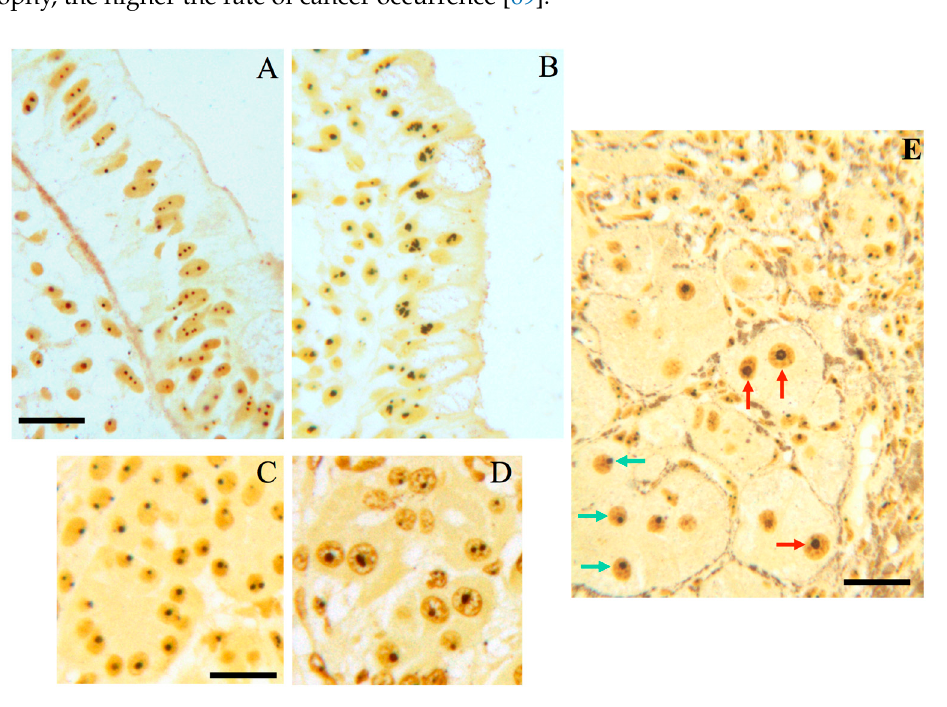
Figure 4. Chronic inflammatory diseases and nucleolar hypertrophy; ( A ) histological sections from normal human colon and ( B ) from human colon with ulcerative colitis (UC), after selective silver staining for NOR proteins. The size of nucleoli of the epithelial cells lining the surface of the normal mucosa is smaller than that of the epithelial cell nucleoli in UC. Bar, 10 µm. ( C ) Histological sections from normal human pancreas and ( D ) with chronic pancreatitis, after selective silver staining for NOR proteins (courtesy of Dr. M. Macchini, San Raffaele Scientific Institute, Department of Medical Oncology, Milan, Italy). Note the larger size of nucleoli of acinar cells in chronic pancreatitis than in normal pancreatic tissue. Bar, 10 µm; ( E ) histologic section from a human hepatitis B virus-related cirrhosis after selective silver staining for NOR proteins. Red arrows indicate hepatocytes with hypertrophic nucleoli, which are close to chronic inflammatory infiltrate. Green arrows indicate hepatocytes with normal-sized nucleoli. Bar, 10 µm.